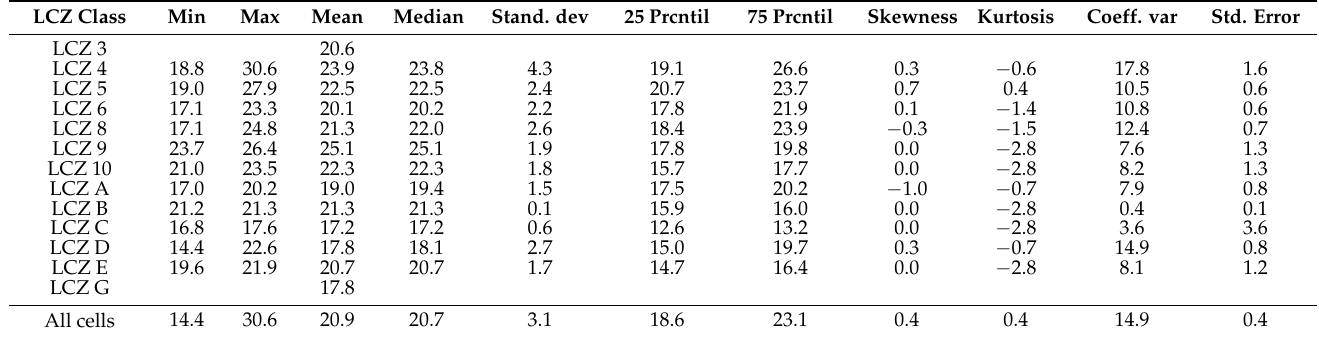
Table 2. LST statistics by LCZs.